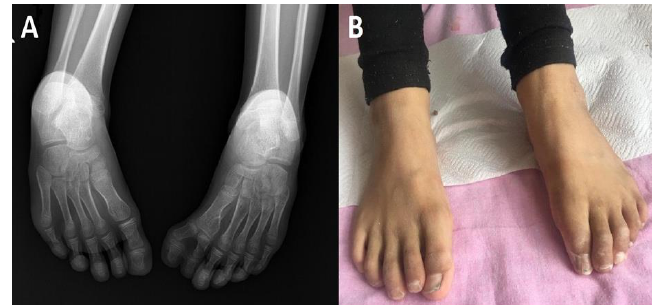
Figure 1. The abnormal feet of the girl patient before and after the surgery. ( A ) Direct radiography of the left bifid big toe with two proximal and two distal phalanxes before the surgery. ( B ) A photo of the feet after the surgery. Longitudinal splitting in the toenails is remarkable.